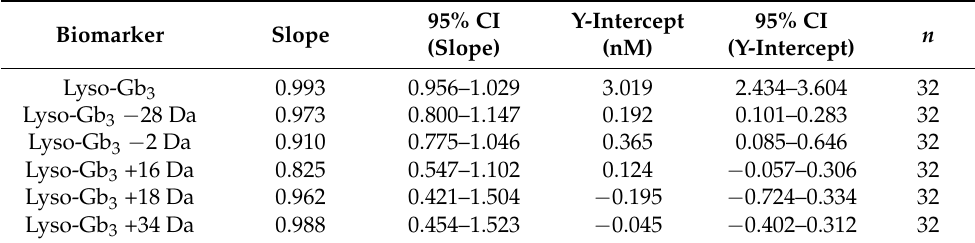
Table 10. Deming regression analysis parameters for lyso-Gb 3 and analogue measurements in plasma and in DBSs collected using Whatman-GE 903 filter papers (capillary blood) ( n = 32 participants).